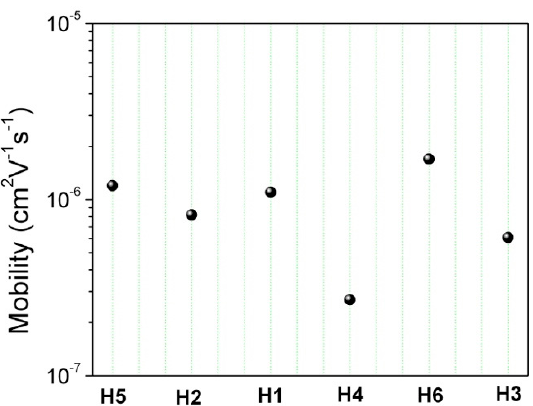
Figure 11. SCLC hole-mobility values for the six materials investigated at zero-field (filled circles). Table 3. Fitting parameters for hole-only devices of Figure 9, extracted from the MG+GDM model.